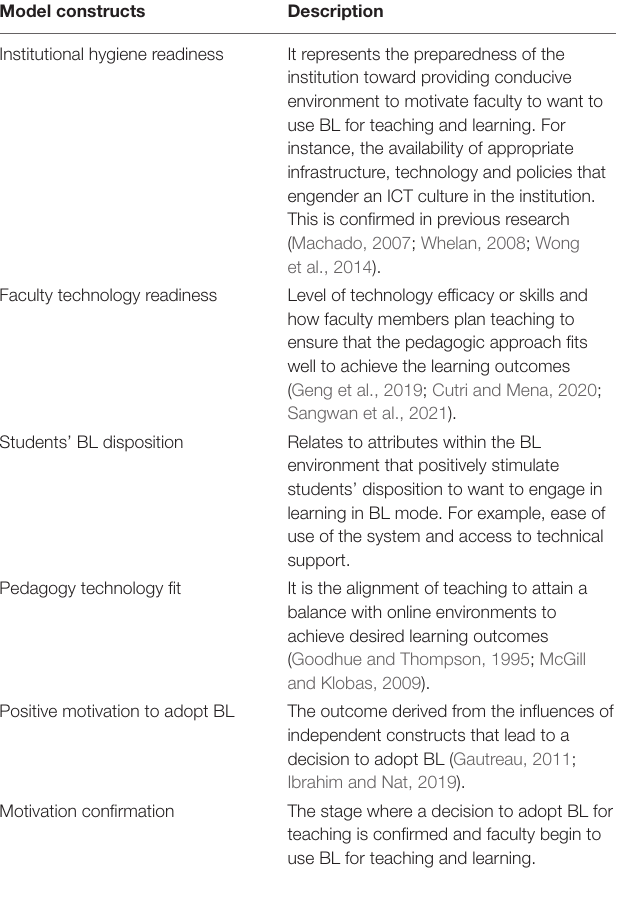
TABLE 1 | Model construct